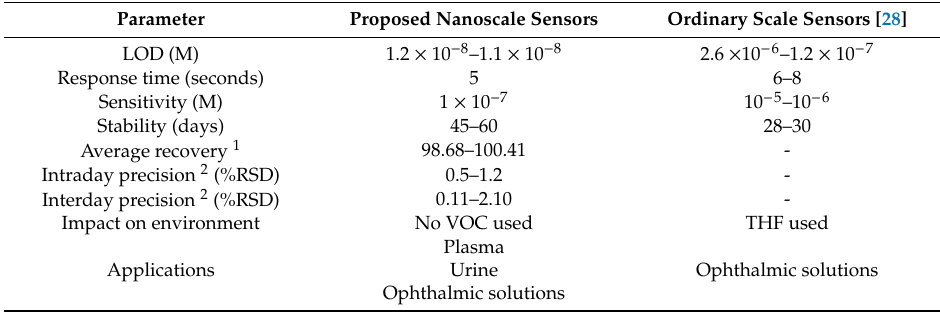
Table 2. A comparison between the proposed sensors and the published electrochemical method [28].